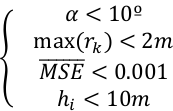
Figure 3. Accessibility analysis. (a) Curb definition within the ground point cloud. (b) A region growing algorithm is applied to divide the ground segment in slides, using the information of trajectory and curbs. (c) The length of the slides is analysed in order to find road entrances as peaks on the slice length